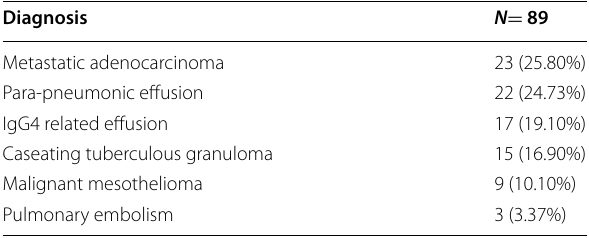
Table 3 The final diagnosis of enrolled patients Table 4 The baseline data of patients with IgG4‑related